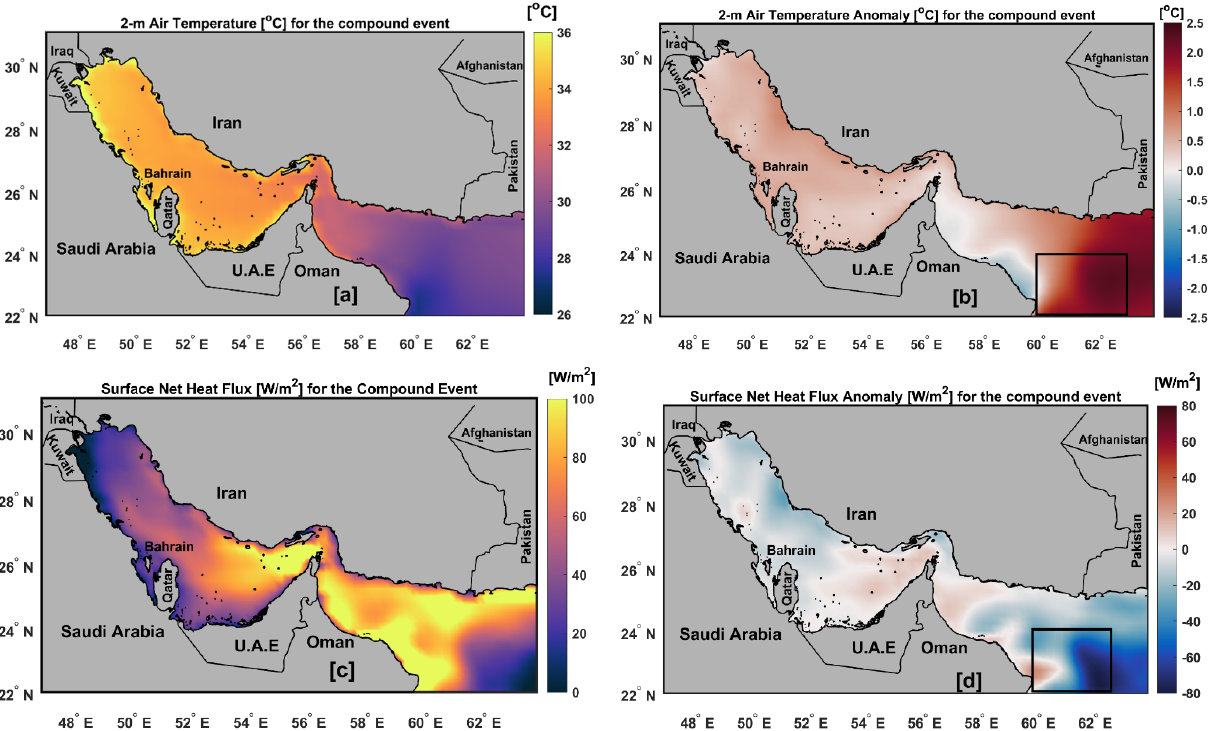
Figure 11. The mean ( a ) and anomaly ( b ) of the 2-m air temperature in [°C]. The mean ( c ) and anomaly ( d ) of the total net surface heat flux in [W/m 2 ] during the longest compound MHW and LChl-a event (10 July–21 August 2020). Note that the anomalies were calculated with respect to the period [1982–2020] from the hourly ERA5 data. The black rectangle in ( b ) and ( d ) defines the area that was affected by the compound event.